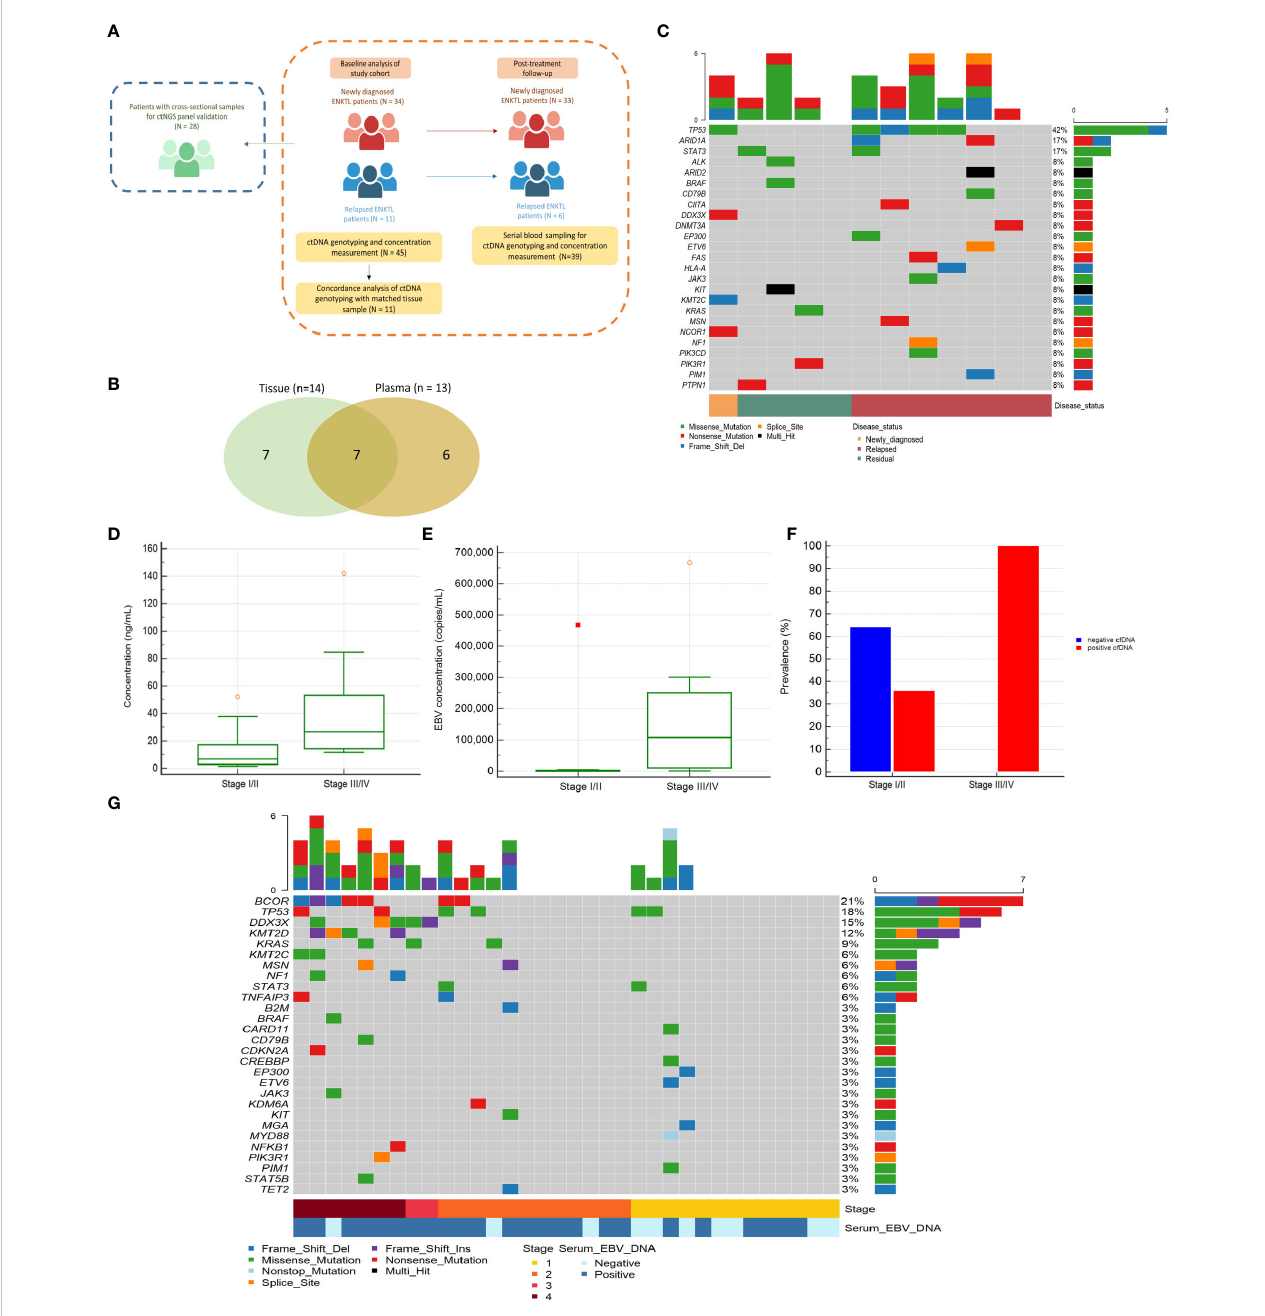
FIGURE 1 (A) Schematic diagram of patient enrollment and specimen collection (B) Concordant and discordant alterations detected in plasma and tissues. Venn diagram representing the number of mutations detected in tissue biopsy samples only, in plasma samples only (ctDNA), and in both samples. (C) Mutational pro fi le of 12 ENKTL patients samples for ctDNA NGS panel validation. Heatmap showing individual non-synonymous Tier I/II somatic mutations detected in the ctDNA samples for panel validation. The top horizontal bar graph shows the gene mutation frequency. (D) Comparison of baseline ctDNA concentration between disease stages among 34 patients initially diagnosed with ENKTL. Comparison of median ctDNA concentrations between early-stage patients (stage I/II, n = 25) and advanced-stage patients (stage III/IV, n = 9). (E) Comparison of median EBV quantitation between early-stage patients (n = 25) and advanced-stage patients (n = 9). (F) Comparison of ctDNA detection between the advanced-stage and early-stage groups in 34 newly diagnosed ENKTL patients. Of the 34 patients, ctDNA was detected in 100.0% (n = 9) of the samples from patients with advanced- stage disease but only in 36.0% (n = 9) of samples from patients with early-stage disease. (G) Non-synonymous Tier I/II somatic variant detection in 34 newly diagnosed ENKTL patients from the study